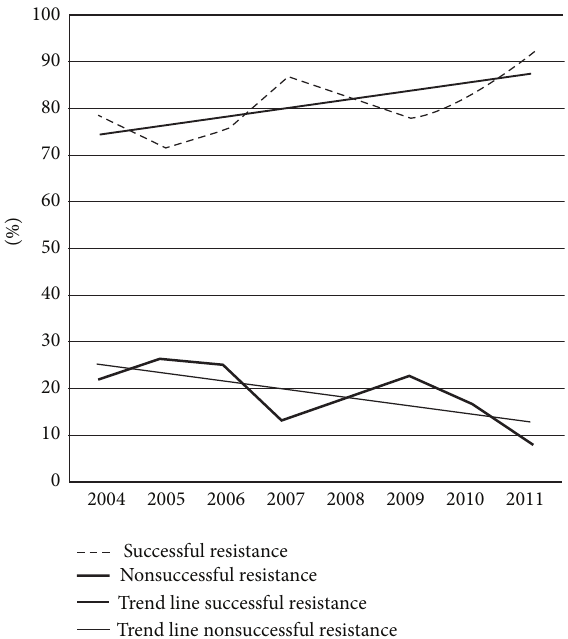
Figure 1: The percentage and trend lines of successful and nonsuc- cessful determination of antimicrobial susceptibility in the consec- utive eight years.